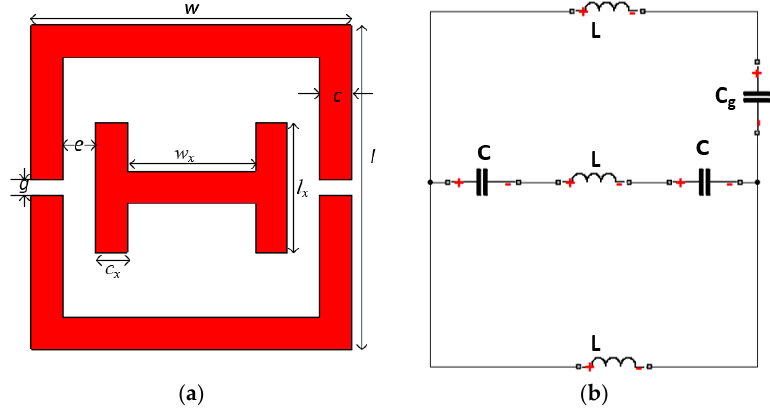
Figure 1. Layout of the proposed unit cell: ( a ) schematic view; ( b ) the equivalent circuit model.